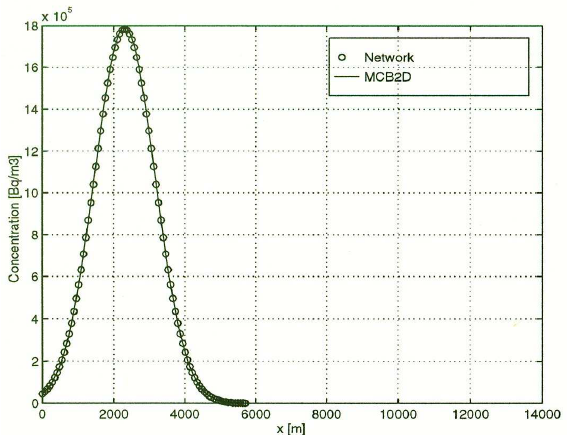
Fig. 4.2. Network 2, v/R=6.45 (cid:215) 10 -4 m/d, e test=10.7%